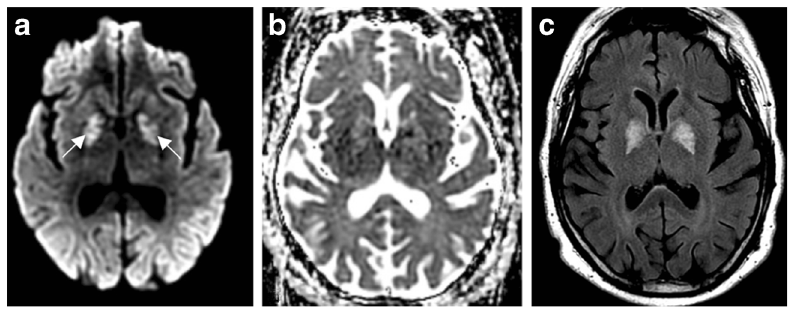
Fig. 3 Carbon monoxide poisoning. Sixty-one-year-old man with history of substance abuse found unconscious. DWI ( a ) symmetric increased signal within the globus pallidus. ADC ( b ) demonstrates